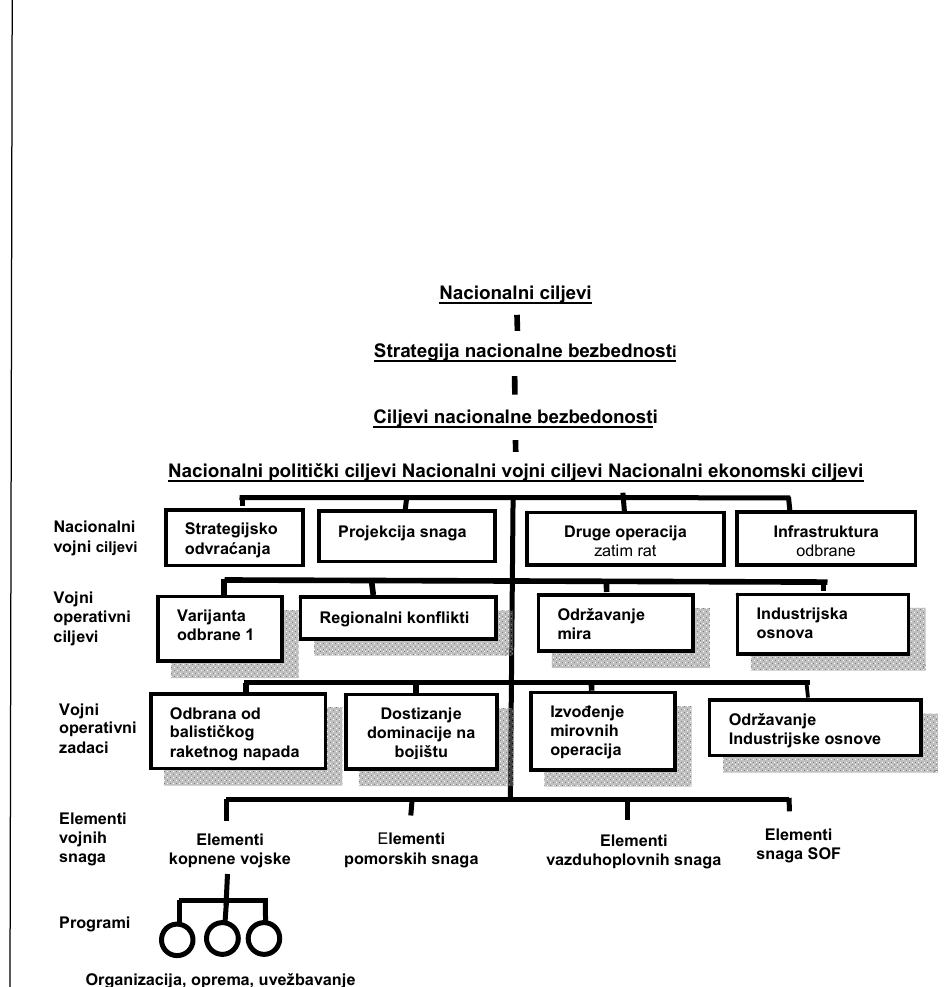
Picture 8 – STT As Applied to the U.S. Army (Lewis, Roll, 1993,